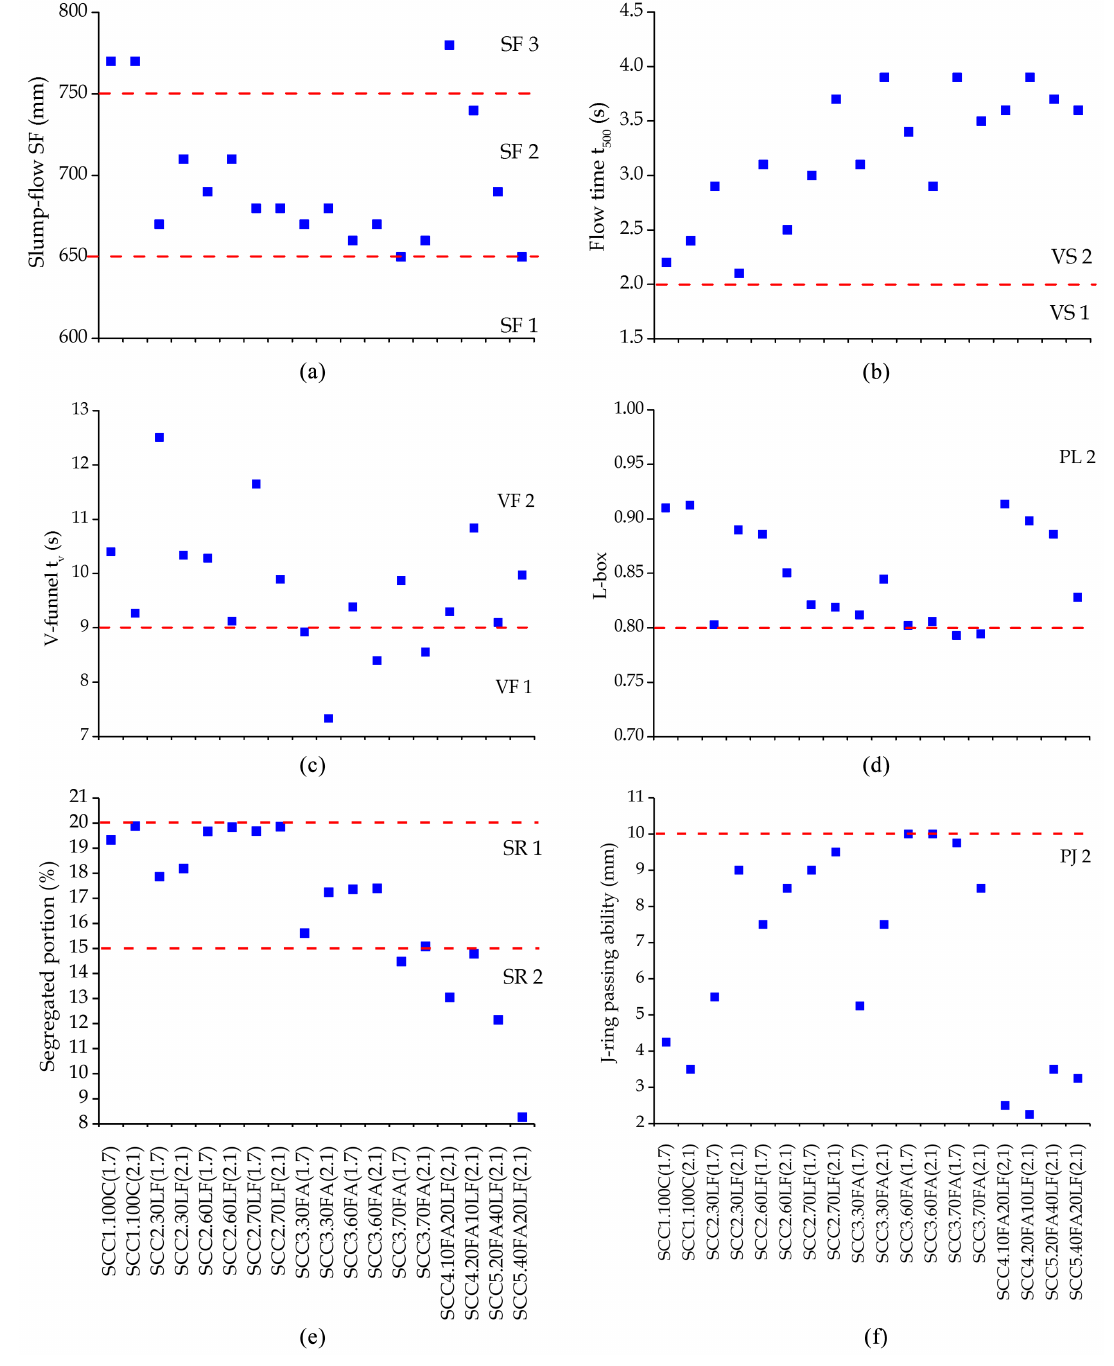
Figure 6. Slump-flow (SF and t